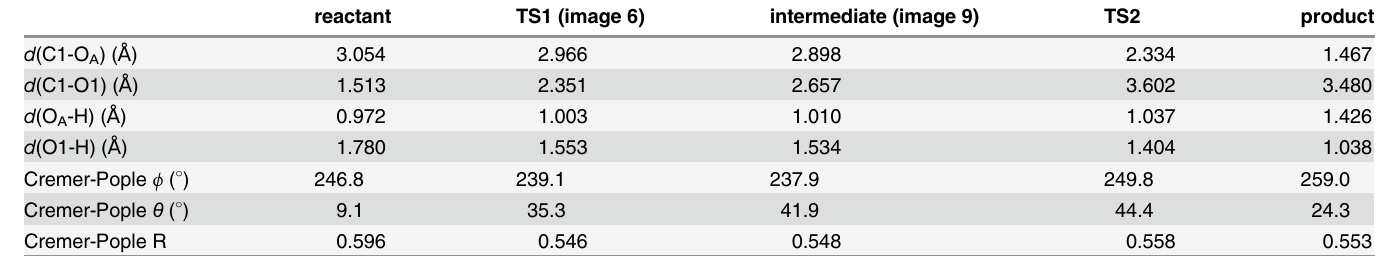
Table 1. Basic parameters of stationary point